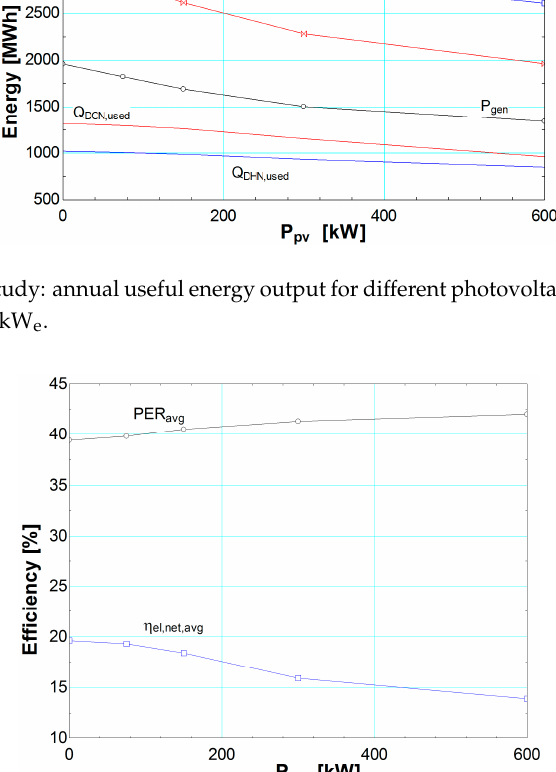
Figure 7. Parametric study: annual average net electrical efficiency and average primary energy ratio (PER) for different photovoltaic subsystem capacities ranging from 0 to 600 kW e .